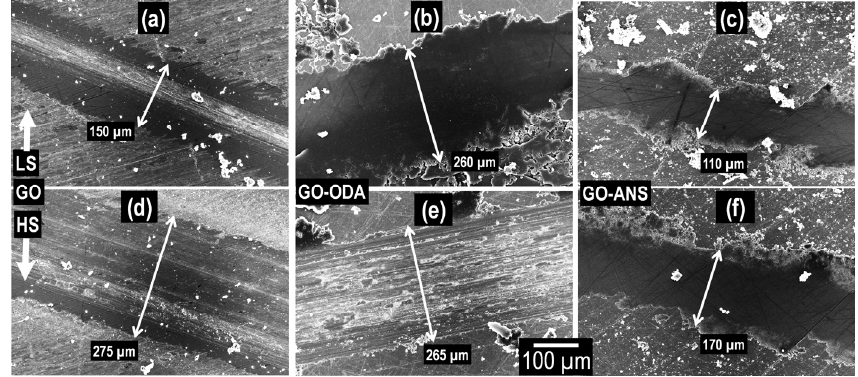
Fig. 10 Post microtribological FE-SEM images and corresponding worn track width of the tribometer track generated for ball loading ( P m ~ 1.1 GPa) on disc surface with (a) GO, (b) GO-ODA, (c) GO-ANS for LS and with (d) GO, (e) GO-ODA, (f) GO-ANS for HS ambient